Question: In one sentence, what is this figure communicating?
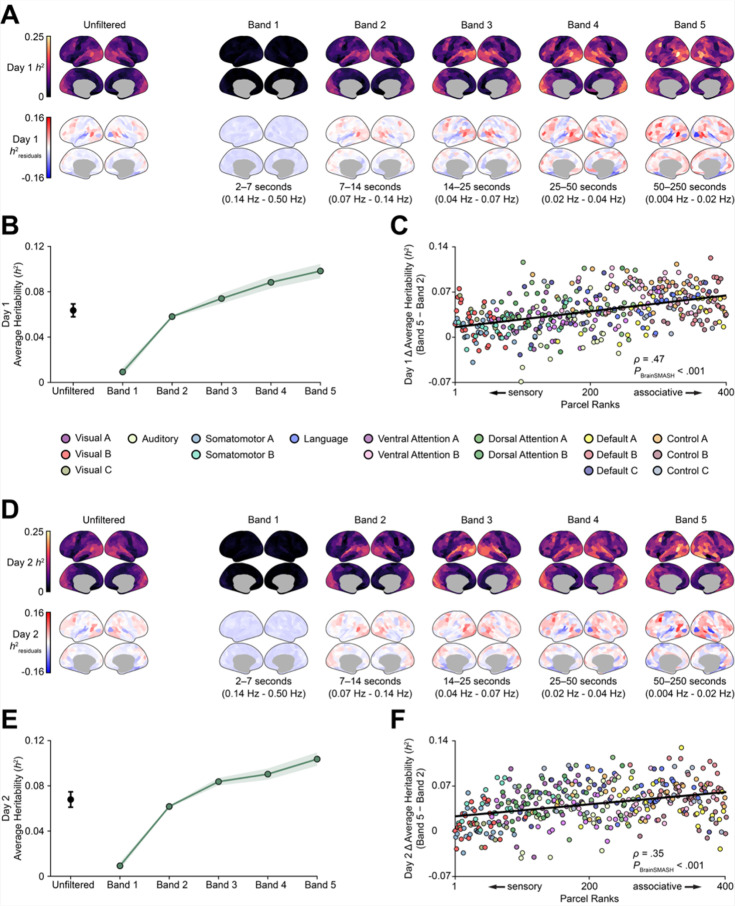
Answer: Blood oxygen level-dependent (BOLD) time course heritability is greater in slower frequency bands, especially for more associative parcels. ( A ) Purple/yellow cortical surfaces (upper row) show unfiltered BOLD time course heritability (upper left is identical to Figure 2A ) as well as the heritability of BOLD time courses filtered with five frequency bands, with greater heritability in slower bands for Day 1 data. Red/blue cortical surfaces show BOLD time course heritability residuals after regressing out parcel- and frequency-level differences in ISC (lower left is identical to Figure 2B ), with greater residuals in slower frequencies and more associative parcels. ( B ) Scatter plot shows heritability averaged across the cortex for each frequency band (i.e. the averages of the upper row of surfaces in A; shading = jackknife SEM). ( C ) Scatter plot shows the difference in heritability between the slowest and fastest BOLD-sensitive frequency bands for each of the Schaefer 400 parcels plotted against parcel ranks from the Sydnor et al. sensorimotor-association hierarchy (higher = more associative). Least squares lines were added to highlight the positive relationships between average h 2 and parcel ranks but note that these relationships were formally tested with Spearman correlations. ( D-F ) Same as A–C for Day 2 data.